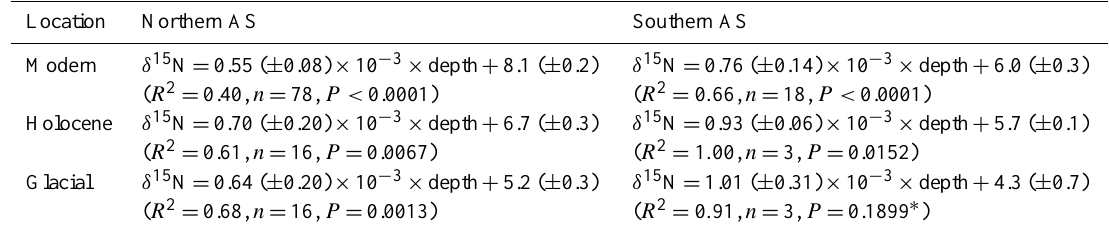
Table 2. Linear equations of bottom-depth effect during different climate stages. Location